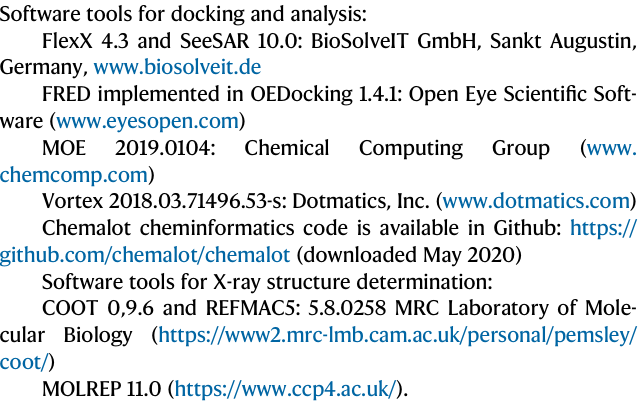
green spheres. A different kinase ligand (PDB ID 3V8S) is shown to illustrate both